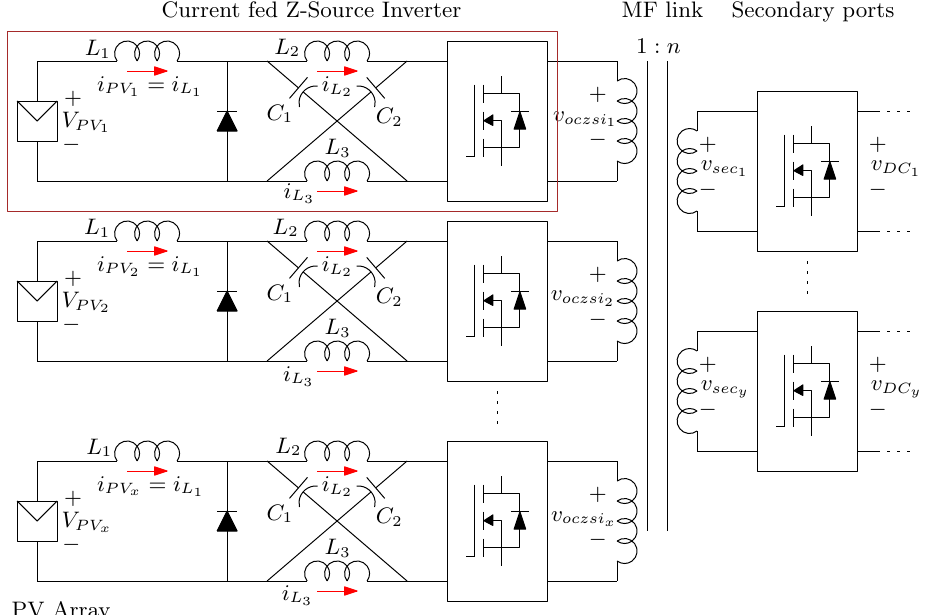
Figure 1. Multiport isolated link system with CZSI input cells to manage asymmetrical power